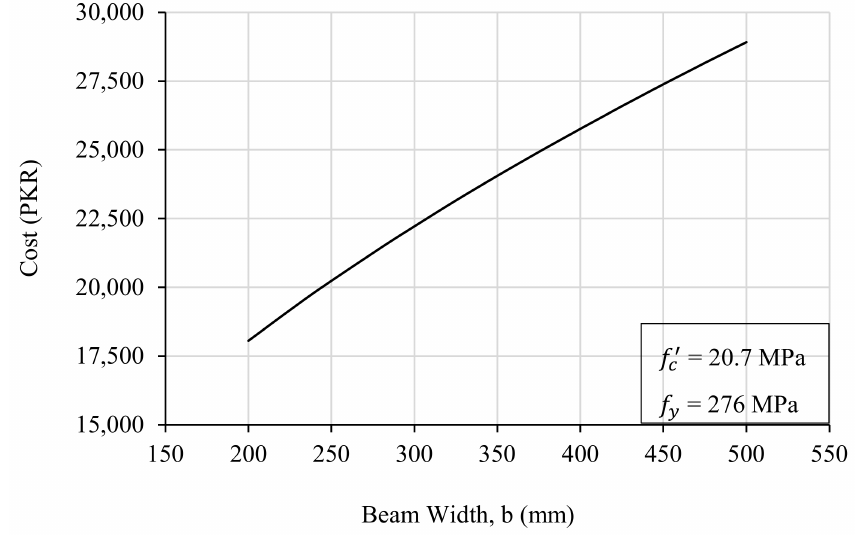
Figure 4. The effect of beam width on the cost of the